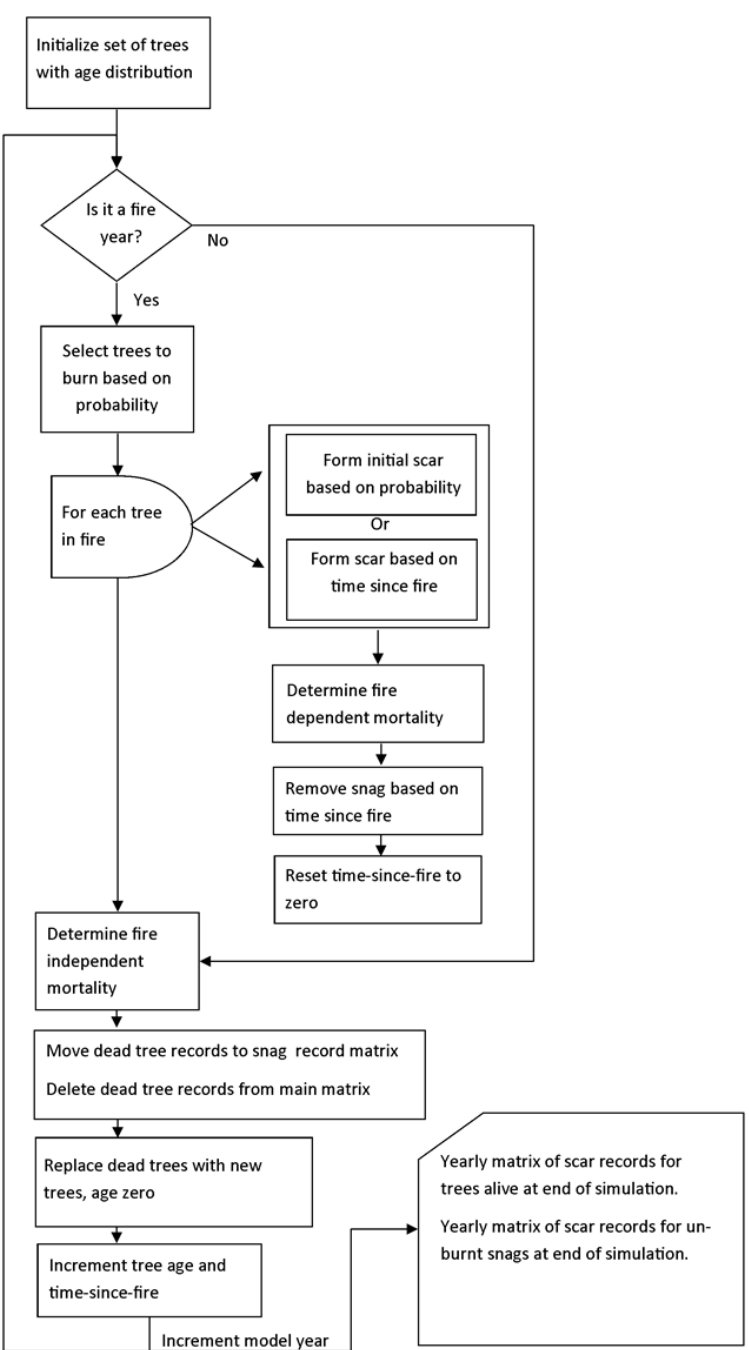
Figure 1. Fire scar simulation flow diagram. Figure A1. Fire scar simulation flow